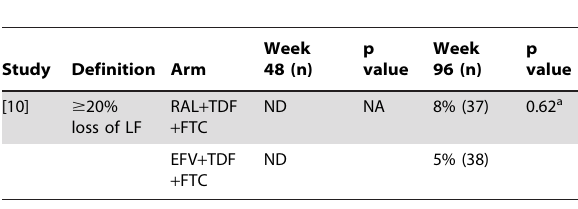
participants both with and without lipoatrophy [14,21]. Three switching studies enrolled only participants with clinical or self- Table 11. Proportion of patients with peripheral lipoatrophy on DEXA scan: raltegravir versus